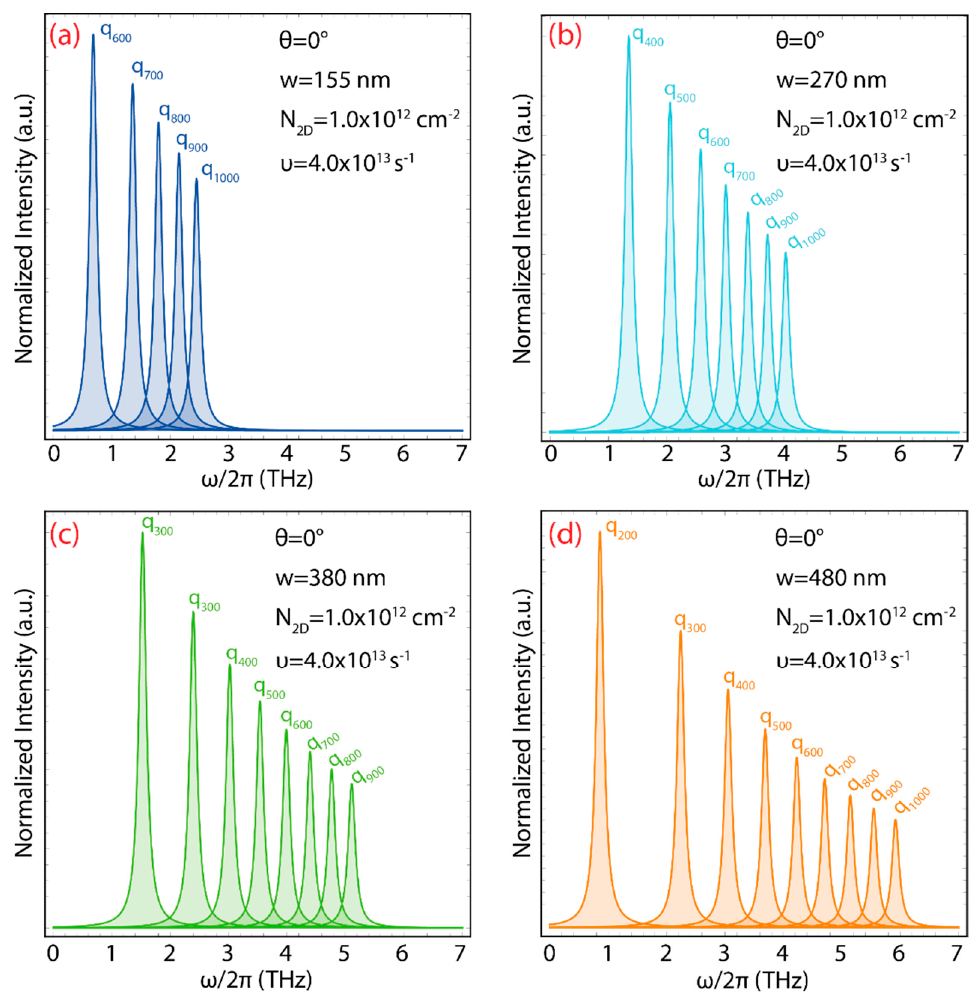
Figure 11. Plasmon excitation lifetime ( ω /2 π ≤ 7 THz) (using θ = 0, N 2 D = 1.0 × 10 12 cm − 2 , ν = 4.0 × 10 13 s − 1 , and v F = 0.829 × 10 6 m s − 1 ) for selected q values from 100 to 1000 cm − 1 , with different ribbon widths: ( a ) w = 155 nm, ( b ) w = 270 nm, ( c ) w = 380 nm, and ( d ) w = 480 nm. The plasmon spectra were calculated using the Lorentzian shape function to a maximum value of 1 with FWHM = 0.25 .